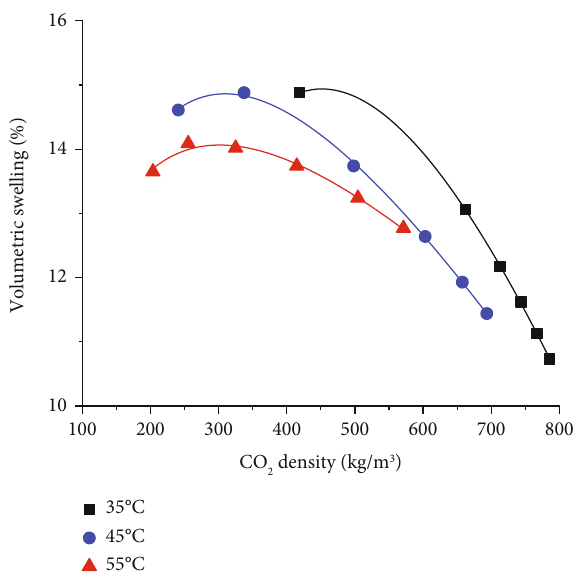
Figure 9: Permeability enhancement ratio with volumetric densities. 2